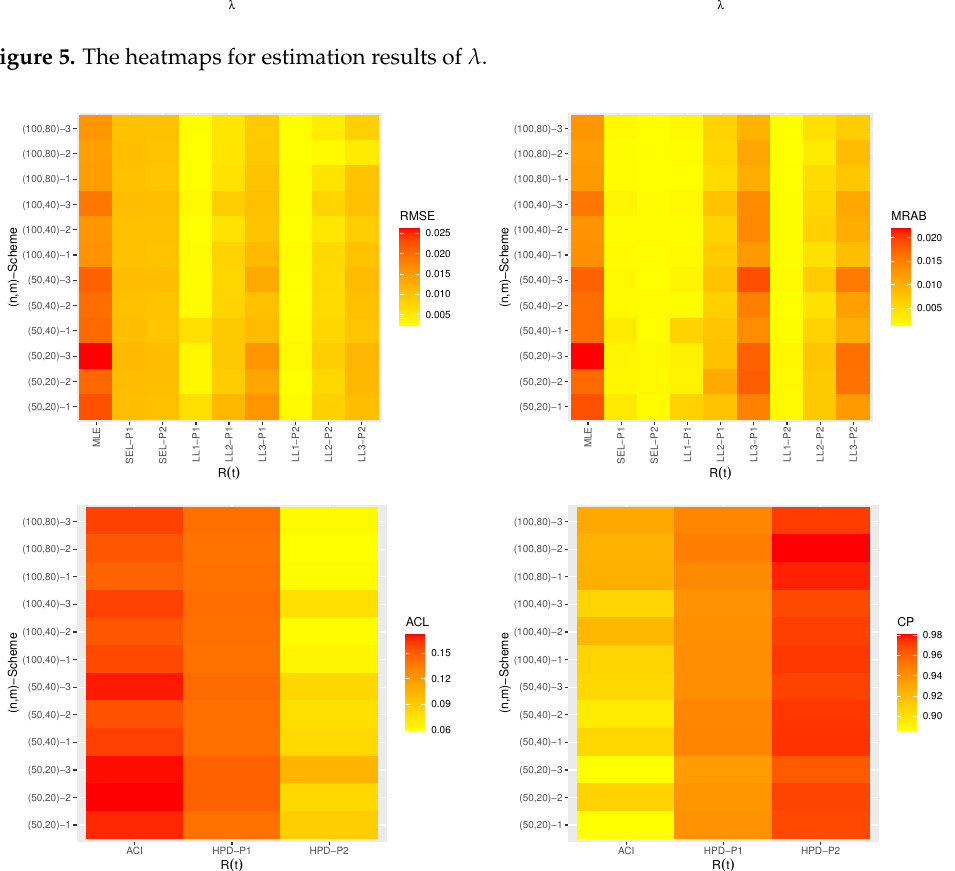
Figure 6. The heatmaps for estimation results of R ( t )